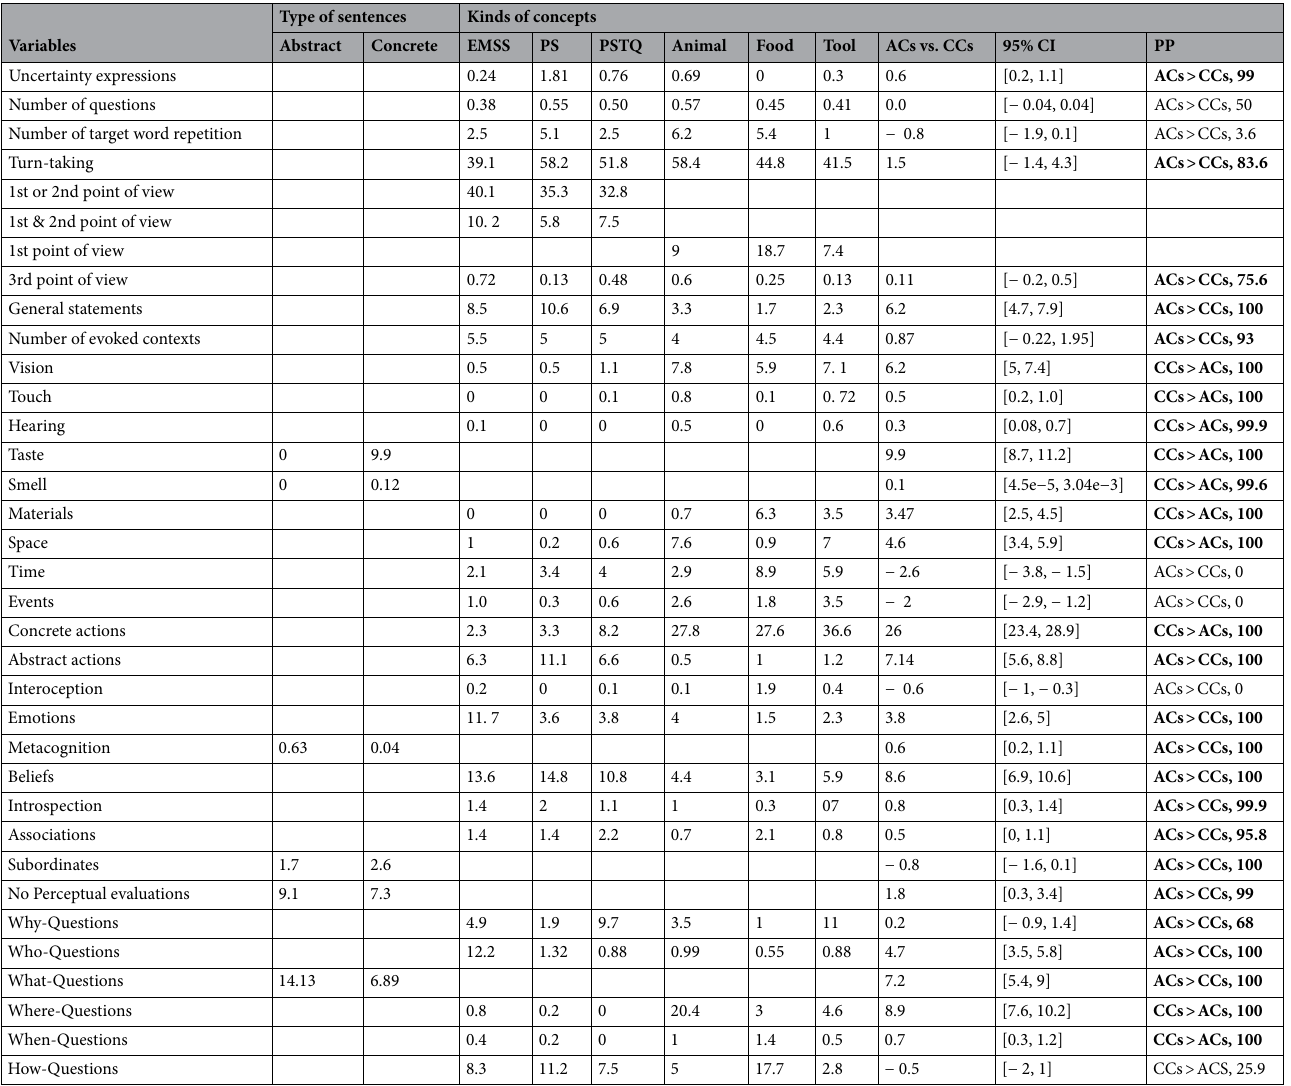
Table 2. Results of Bayesian linear mixed effect models. We showed the main probability of conditional effects according to the type of sentence (abstract, concrete) or kind of concepts (i.e., emotional EMSS, philosophical PS, quantitative PSTQ, Animals, Food, Tool) in each variable. We report the percentage of all variables for each kind of sentence, with the exception of the variables “number of questions” and “numbers of evoked contexts” where the count frequency is reported. This discrepancy is due to the fact that for the variables “number of questions” and “number of evoked contexts” we did not have a total numerical reference value, while for the others we had it, consequently we reported the percentages . For each variable, we report the comparative analysis between Abstract and Concrete sentences (ACs vs. CCs) and the 95% Credible Intervals (CI) and the probability of posterior observations major to zero (PP > 0) reported in percentage terms according to our hypothesis. The PPs values highlighting meaningful differences are in